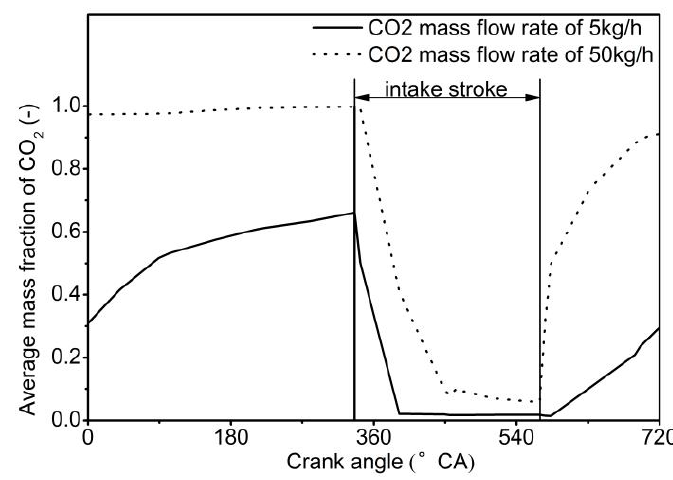
Figure 8. Average CO 2 mass fraction at the outlet of intake port 1 of cylinder 1 versus the crank angle with different mass flow rates of CO 2 .